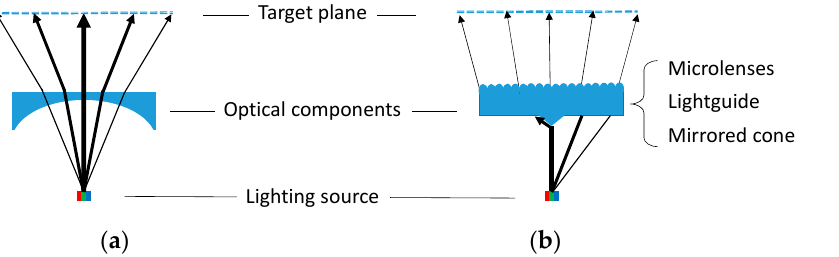
Figure 1. Schematic diagram of ( a ) traditional lens design and ( b ) proposed design consists of a mirrored cone, a waveguide, and microlenses.